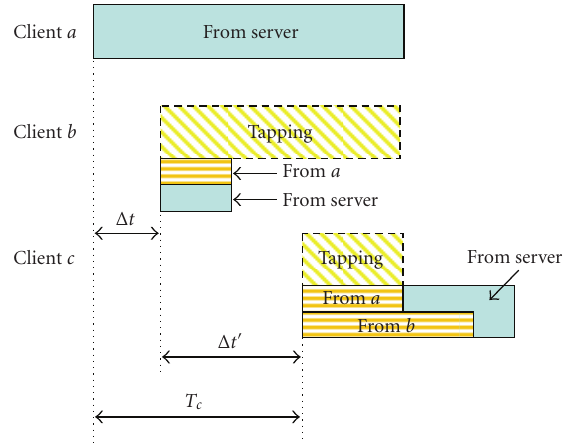
Figure 3: How the full tap streams are distributed among the server and the previous